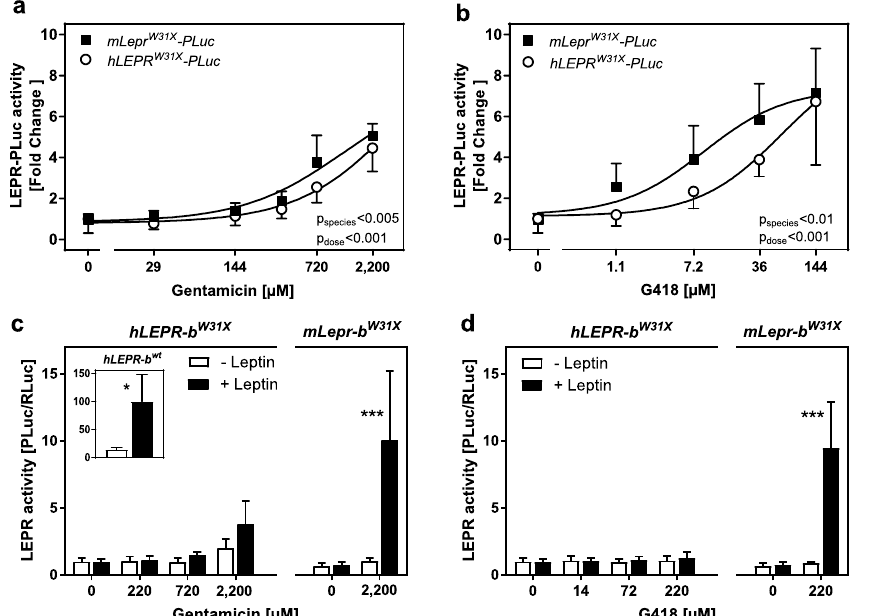
Figure 4. Aminoglycoside treatment of human LEPR W31X . ( a , b ) HEK293 cells were co-transfected with the mLepr W31X - PLuc or hLEPR W31X - PLuc fusion construct (embedding the W31X either into mouse or human ± 6 bp context) and phRG-b. Two days after the transfection, cells were treated for 24 h with rising concentrations of ( a ) gentamicin or ( b ) G418 (n = 7–8, SD). P-values indicate the outcome of two-way ANOVA with aminoglycoside treatment and species context as independent variables. ( c , d ) HEK293 cells were co- transfected with either the hLEPR - b W31X -pDEST26 or mLepr - b W31X -pcDNA3.1 full-length overexpression construct, STAT3-RE-PLuc and phRG-b. One day after the transfection, cells were treated for 48 h with different concentrations of the aminoglycosides gentamicin ( c ) or G418 ( d ) and for the last 16 h in addition with 16 nM human or 6 nM murine leptin, respectively. Inset in ( c ) shows signalling of hLEPR - b wt (n = 4–6, SD). Statistical significance was assessed by t-tests with Bonferroni-Holm correction for multiple comparisons * p < 0.05; *** p <